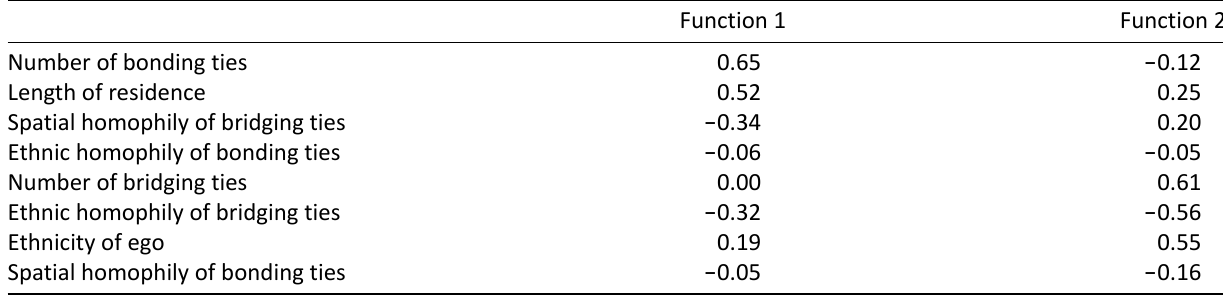
Table 5. Structure matrix of the discriminant analysis.